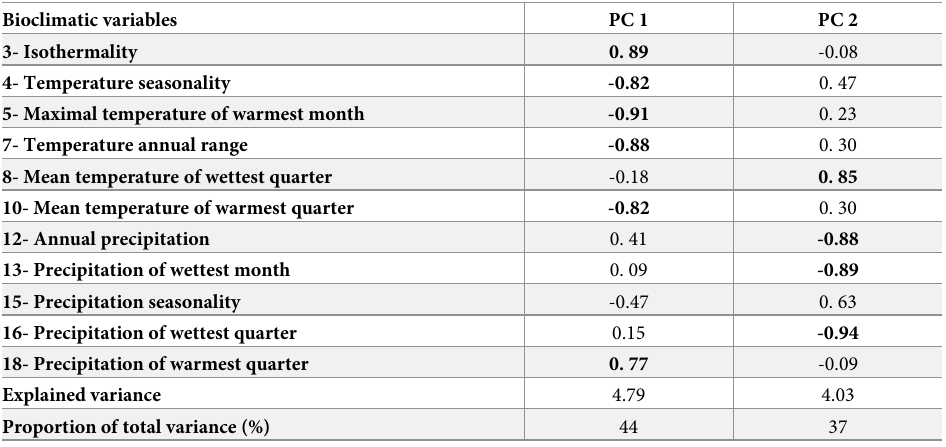
Table 3. Principal component analysis (varimax normalized rotation) on S . gesnerioides bioclimatic envelope. Bioclimatic variables PC 1 PC